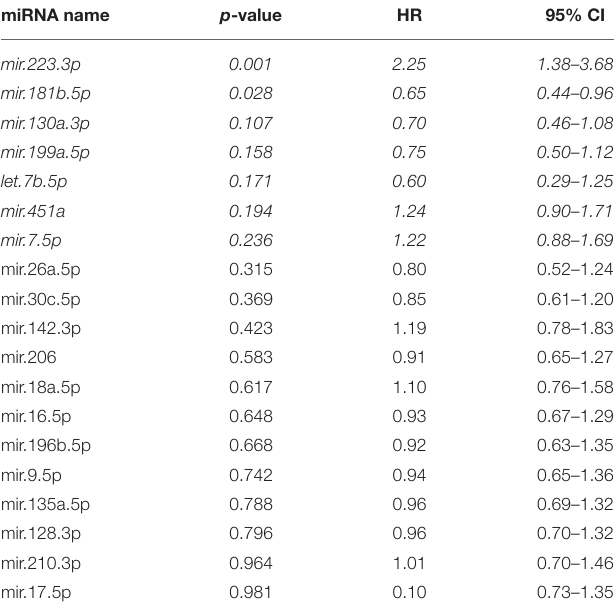
TABLE 1 | Results of univariate Cox proportional hazard regression analysis for expression of miRNAs in canine osteosarcoma tumors ( n = 33; disease-free interval range, 20–937 days).